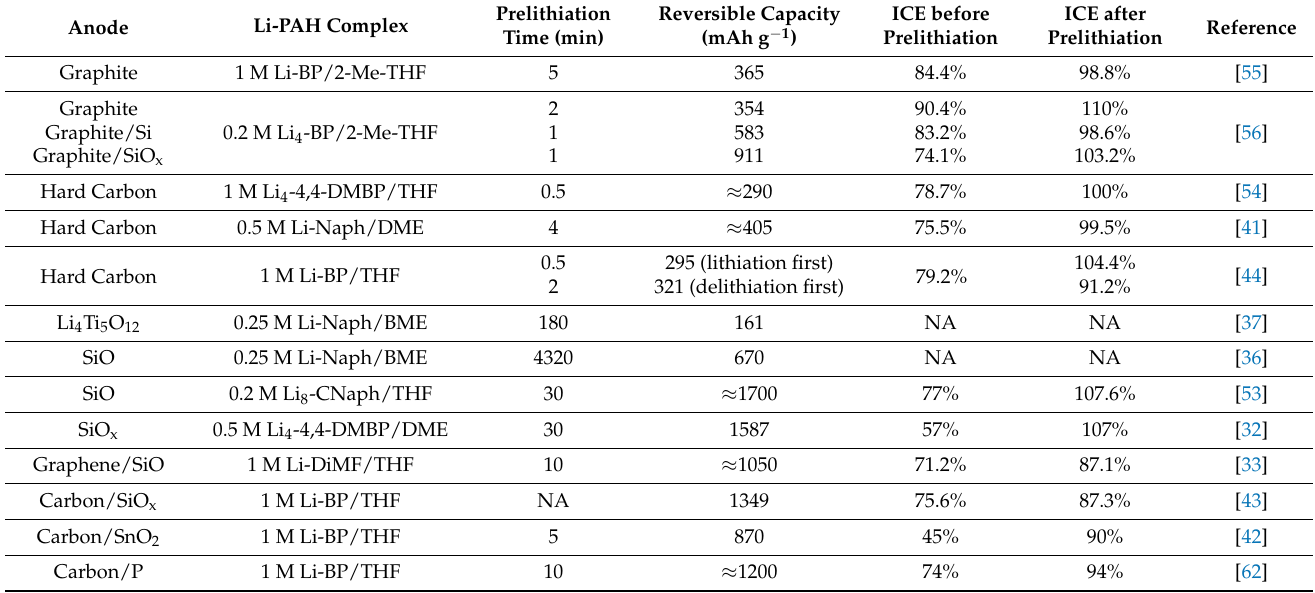
Table 2. Summary of prelithiated anode performance adopting various Li-PAH